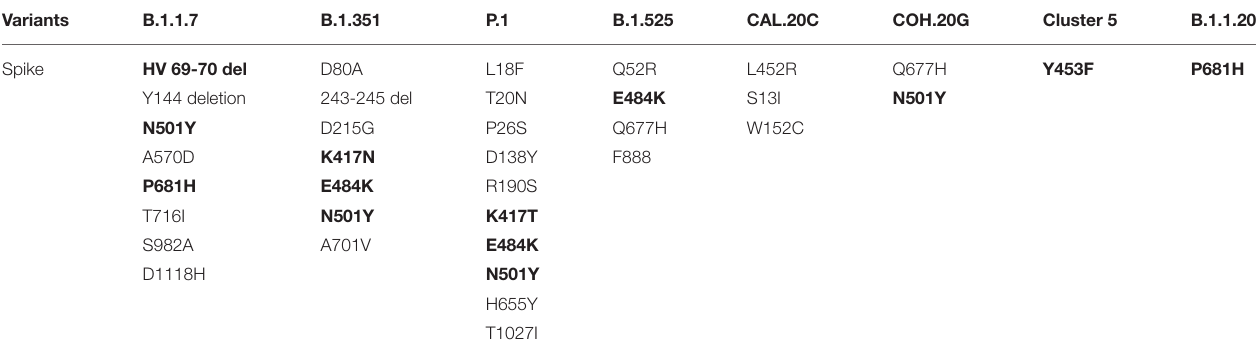
TABLE 1 | New variants of amino acid mutations in the S